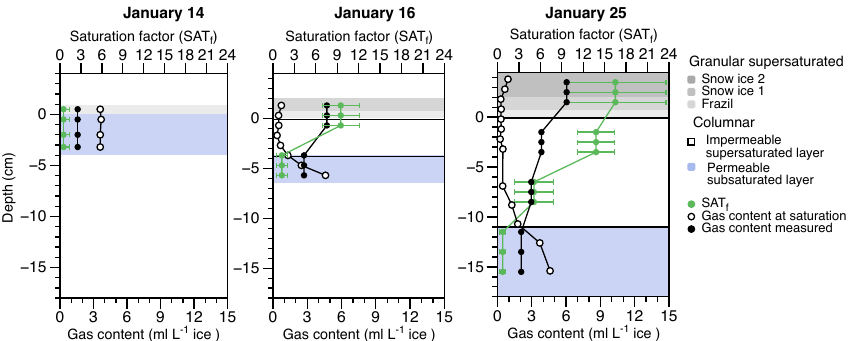
Figure 6. Profiles of the total gas content in bulk sea ice measured by gas chromatography as the sum of O 2 , N 2 and Ar (black symbols) com- pared (i) to the theoretical bulk ice gas content at atmospheric saturation (white symbols) and (ii) the saturation factor (green symbols). The blue area highlights subsaturated columnar sea ice (SAT f ≤ 1.2), the white area highlights the supersaturated columnar sea ice (SAT f > 1.2) and the grey area represents successively the supersaturated granular layers (frazil and snow ice layers).